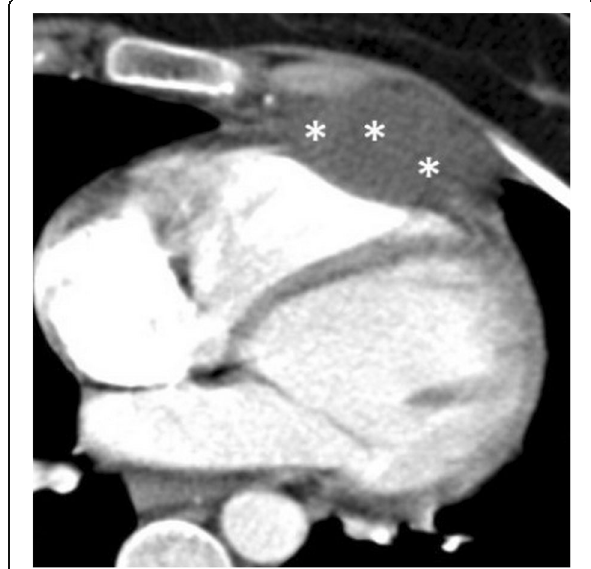
Fig. 17 A 28-year-old woman with pathologically proven metastatic osteosarcoma. Axial contrast-enhanced CT image reveals a lobulated hypodense mass (asterisks) invading the anterior aspect of the right ventricle and pericardium